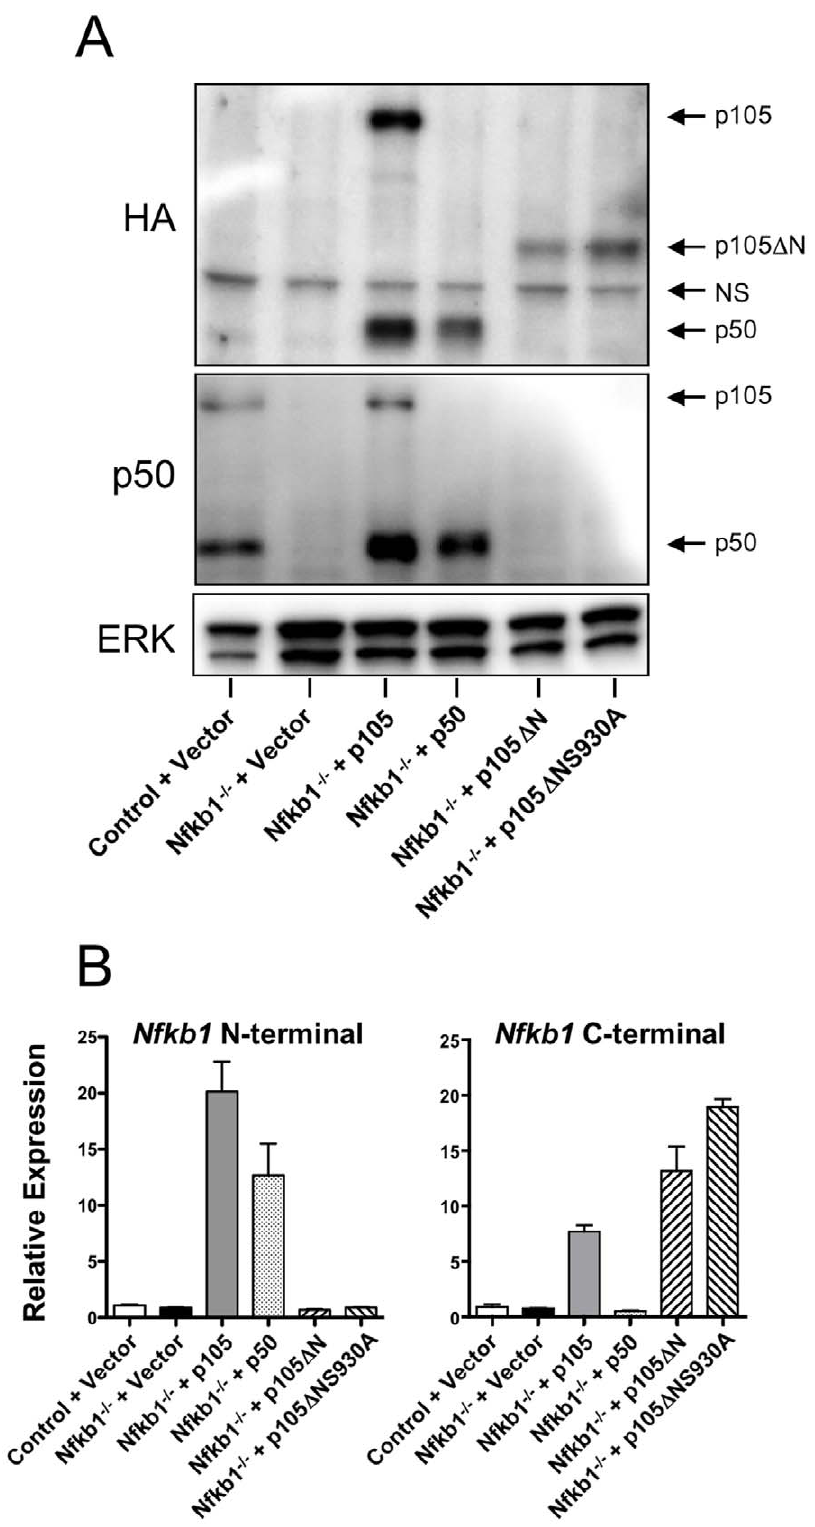
Figure 2. Retrovirally-mediated expression of Nfkb1 constructs. A) Immunoblotting of Il10 2 / 2 Rag2 2 / 2 (Control) or Nfkb1 2 / 2 Il10 2 / 2 Rag2 2 / 2 ( Nfkb1 2 / 2 ) BMDM infected with empty vector (Vector) or viruses expressing the indicated proteins. Total cell extracts from unstimulated cells were probed with the indicated antibodies (left) by western blotting. Arrows indicate size of Nfkb1 -derived gene product (right). NS refers to a non-specific band. B) Relative expression of Nfkb1 N- and C-terminal derived mRNA as determined by RT-PCR. N=3 mice per group.